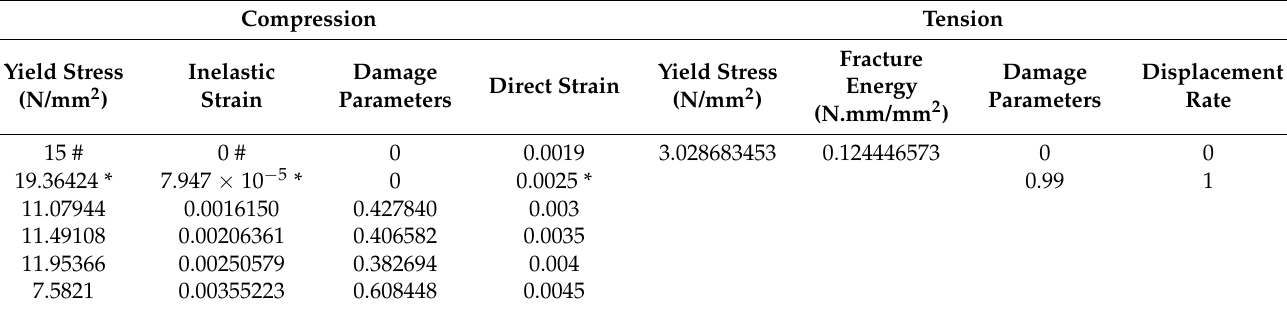
Table A3. Concrete compression and tension damage data for the GFC-1.